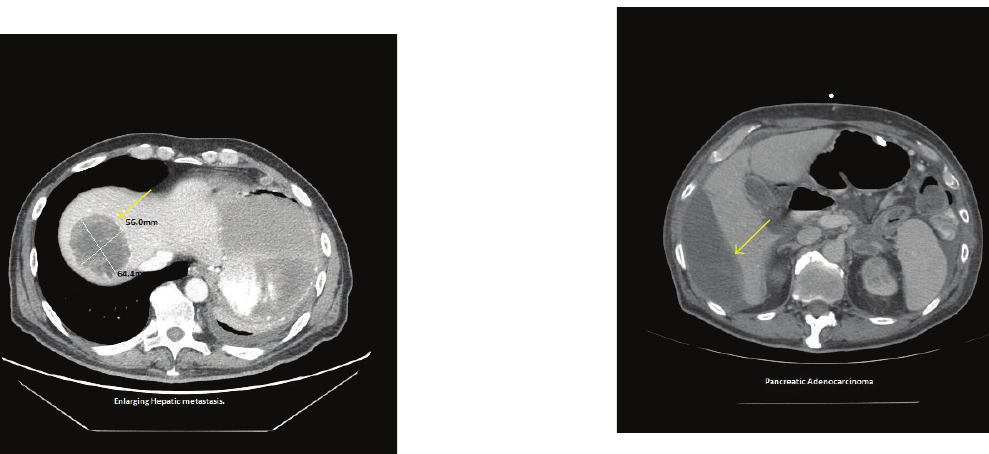
Figure 4: Axial contrast enhanced CT obtained 4 months after study in Figures 1 and 3 showing decreasing size of subcapsular liver